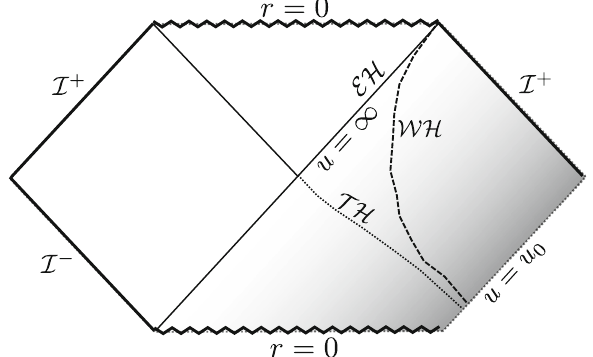
Fig. 1 Schematic Penrose conformal diagram of Robinson–Trautman spacetime (the shaded portion) which exists for any smooth initial data given on u 0 . For u → ∞ it approaches the spherically symmet- ric Schwarzschild solution by emitting gravitational radiation towards future null infinity, and can be extended through the future event hori- zon EH to the interior Schwarzschild solution and the other asymptotic region(thewhiteportion).Thecurvaturesingularitiesareat r = 0,thick lines represent future and past null infinities I + and I − . The white hole is localized by a trapping (apparent) horizon T H indicated by dotted line.Thewormhole throat WH (dashedline)sitsabovethishorizonand asymptotically approaches the future Schwarzschild horizon at u = ∞ . In the wormhole case only the portion of the diagram to the right from the throat (dashed line) is applicable and is glued to its copy along the dashed